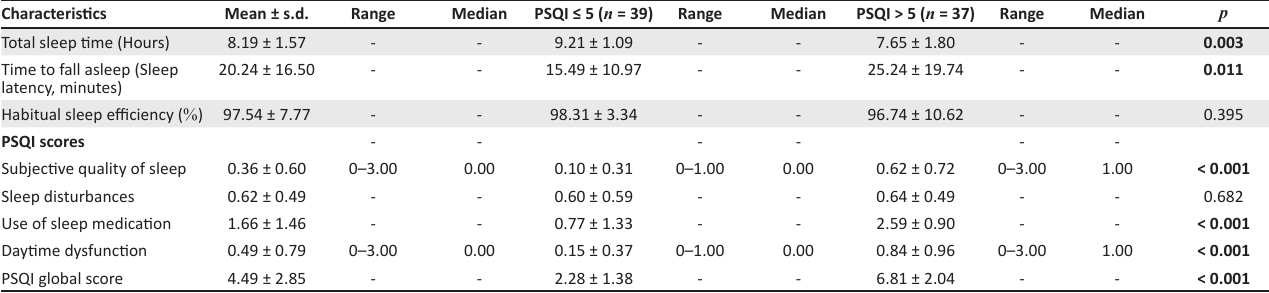
TABLE 2a: Characteristics of sleep quality in bipolar patients. Characteristics